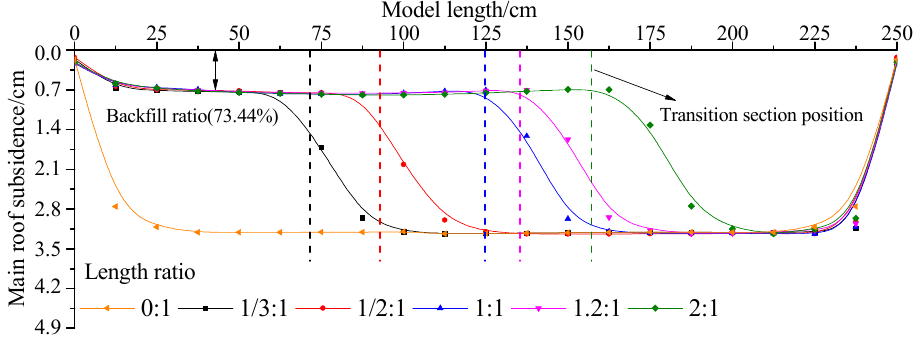
Figure 6. Main roof subsidence curve.